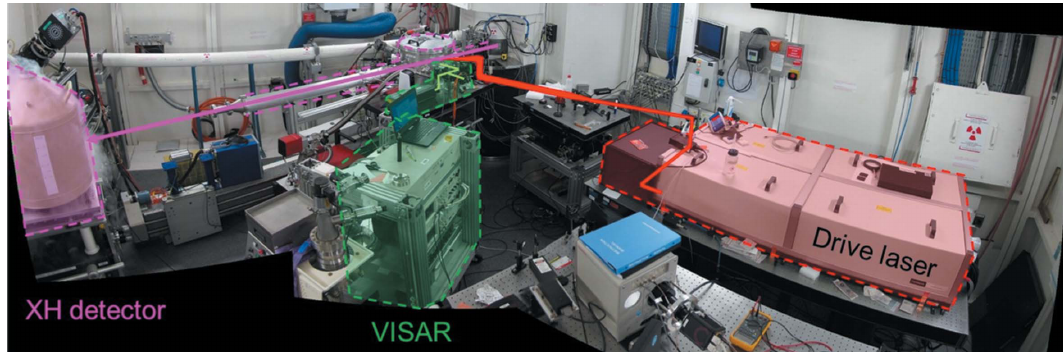
Figure 6 A photograph of the experimental hutch in November 2018. Beams are shown as solid arrows, whereas instruments are shown as dashed lines. X-rays are shown in pink, the drive laser in red and the shock diagnostics in green. For scale, the laser is 2 m